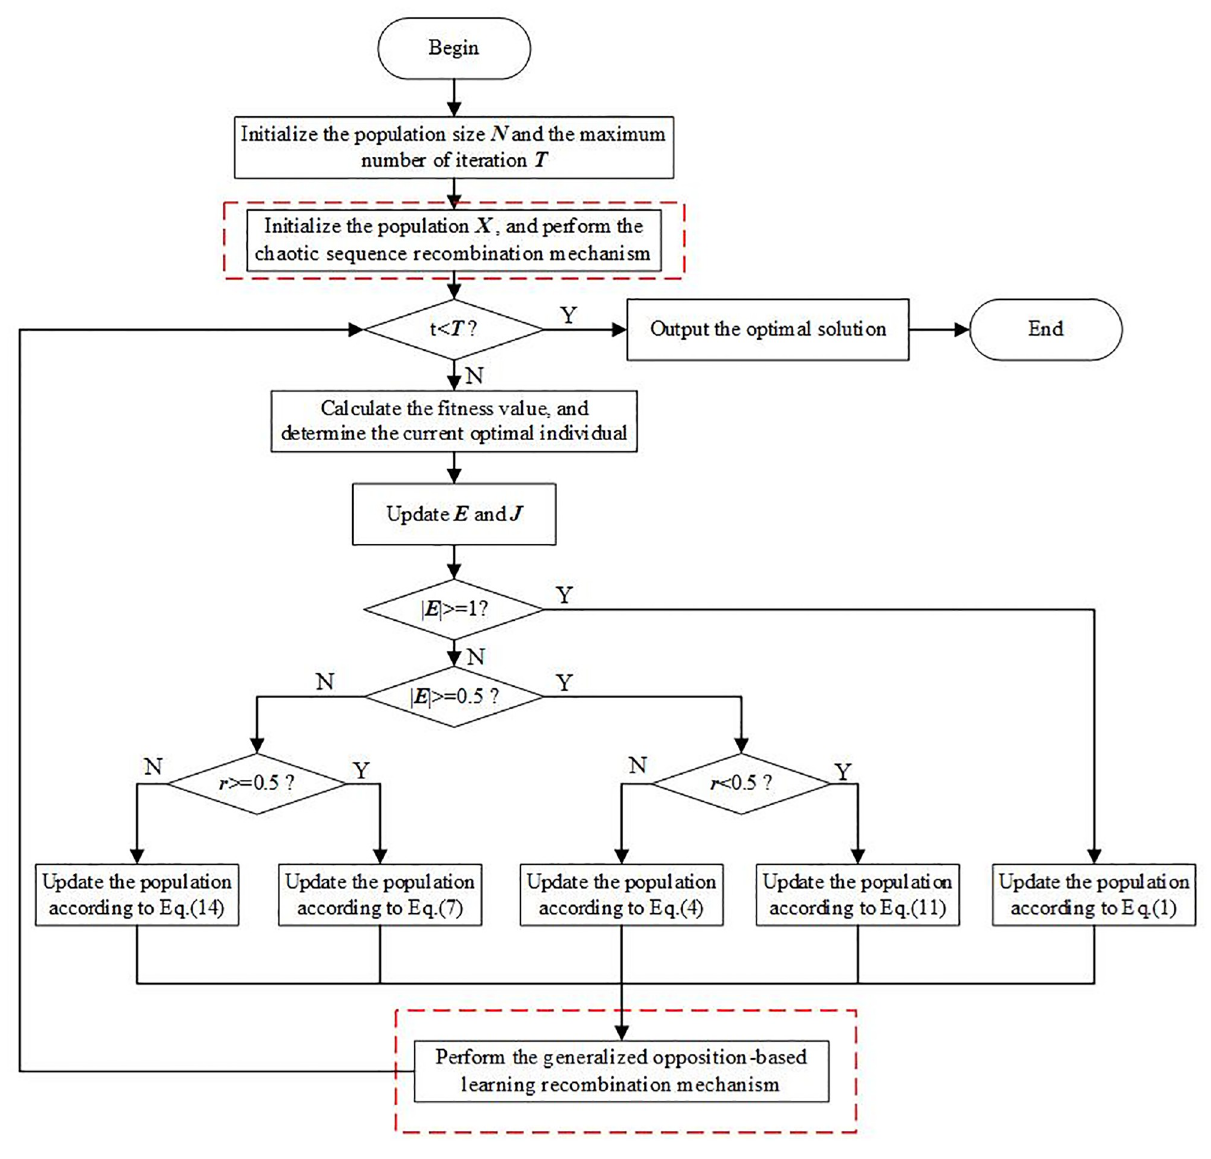
Fig 3. Flow chart of the proposed